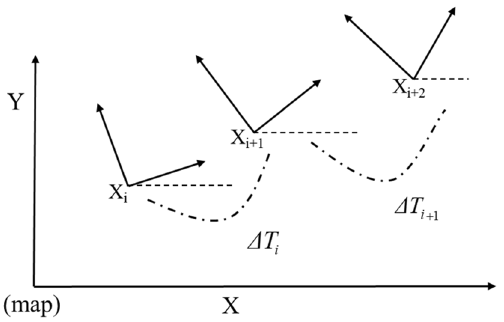
Figure 9. Pose and time interval of mobile robot in the world coordinate